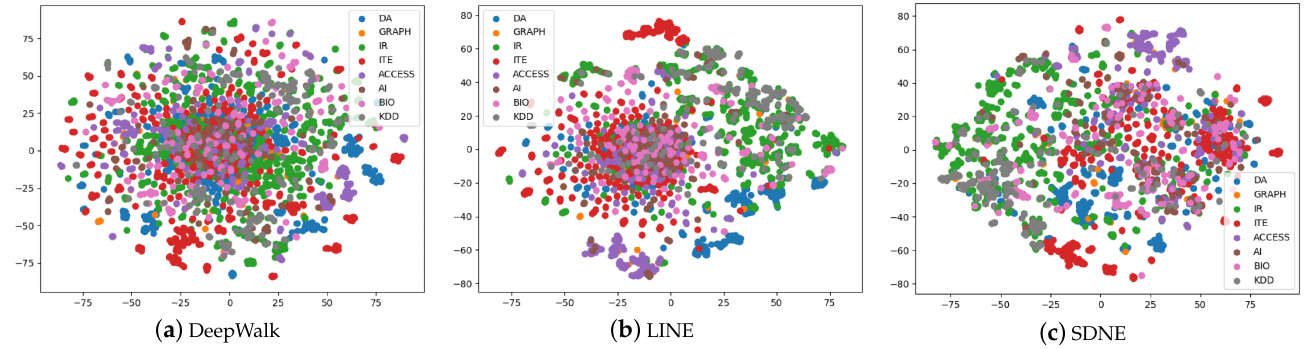
Figure 7. A comparison of the visualization results of the three methods for the SIG dataset. ( a ) The result of DeepWalk, ( b ) the result of LINE, and ( c ) the result of structural deep network embedding (SDNE). Differently colored nodes rep- resent different categories. The dataset contains eight categories (Ada programming language (DA); computer graphics (GRAPH); information retrieval (IR); information technology education (ITE); accessibility and computing (ACCESS); artificial intelligence (AI); computational biology (BIO); knowledge discovery in data